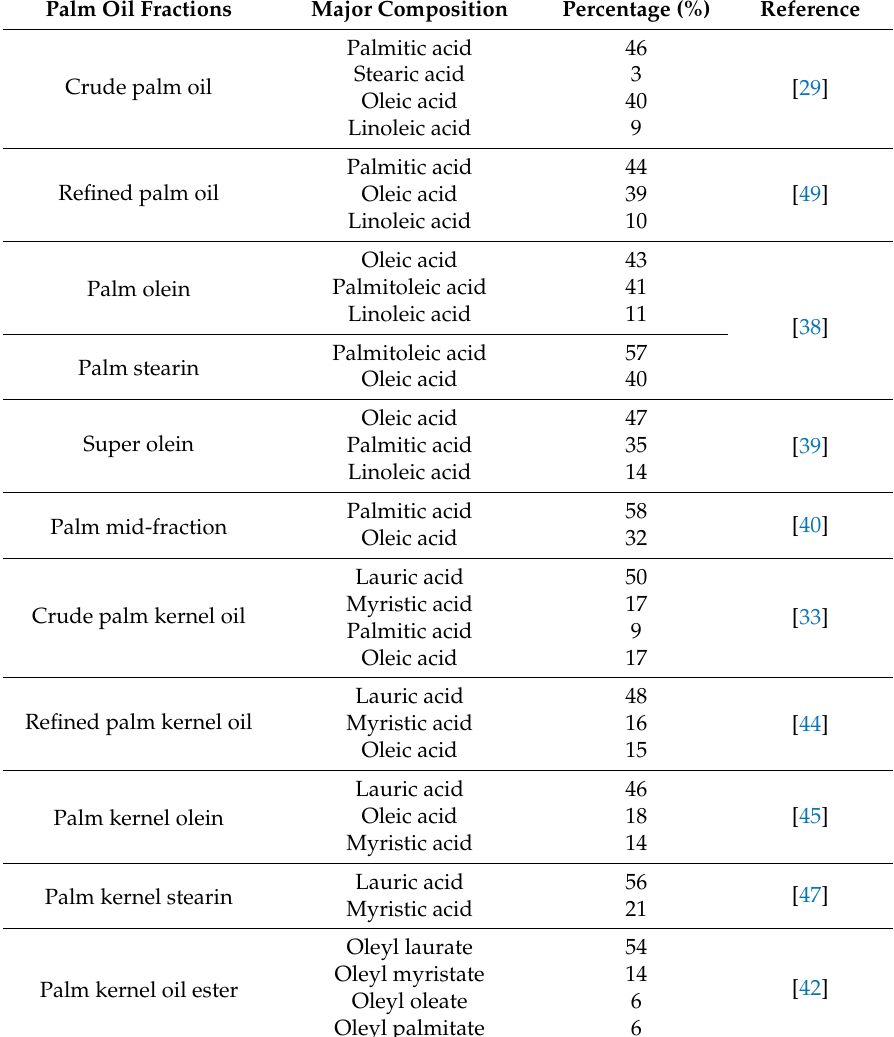
Table 1. The major compositions and percentages of fatty acids in palm oil and its